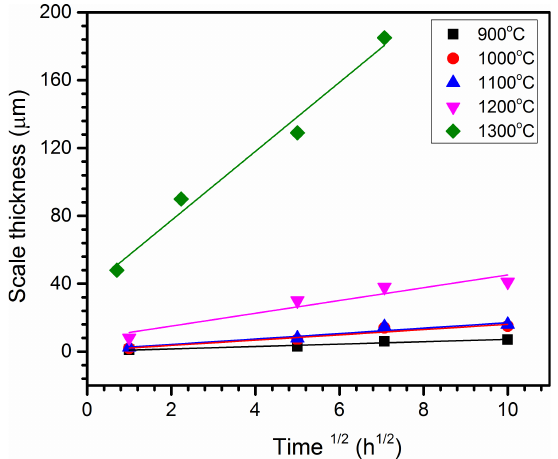
Figure 8: BSE image showing the microstructure of the oxide scale and the alloy